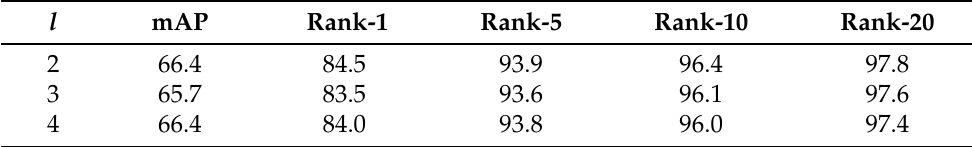
Table 3. Parameter l influence on the